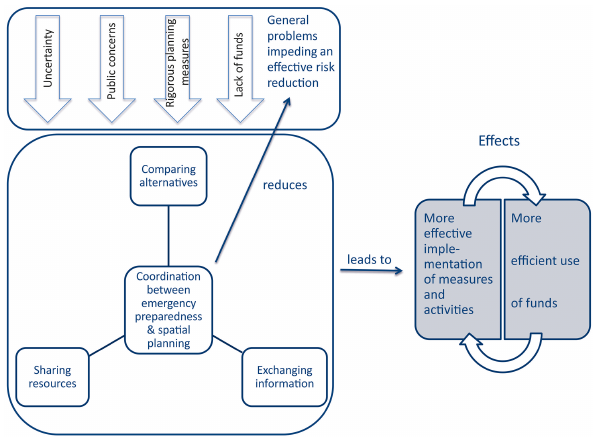
Figure 8. Effects of improved coordination between emergency preparedness and spatial planning actors and identified problems (uncertainty in natural hazard prediction, multitude and complexity of concerns of local authorities, rigorous spatial planning measures, lack of funds) impeding effective risk reduction, benefitting from improved